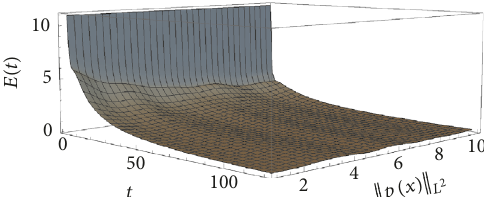
Figure 1: Synchronization error as function of the time and the intensity of the perturbation defined as ‖𝑝(𝑥)‖ 𝐿 2 .